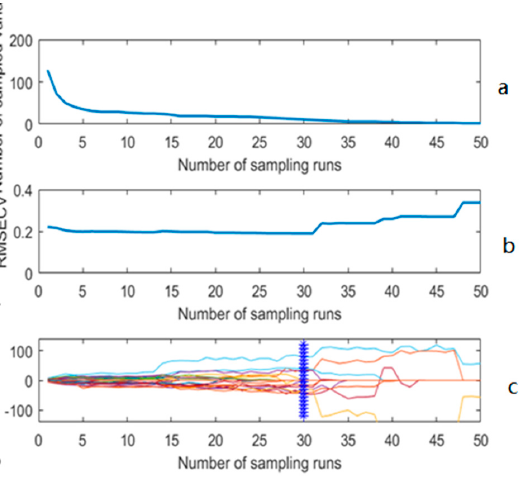
Figure 5. The effective wavelength selected by competitive adaptive reweighted sampling.